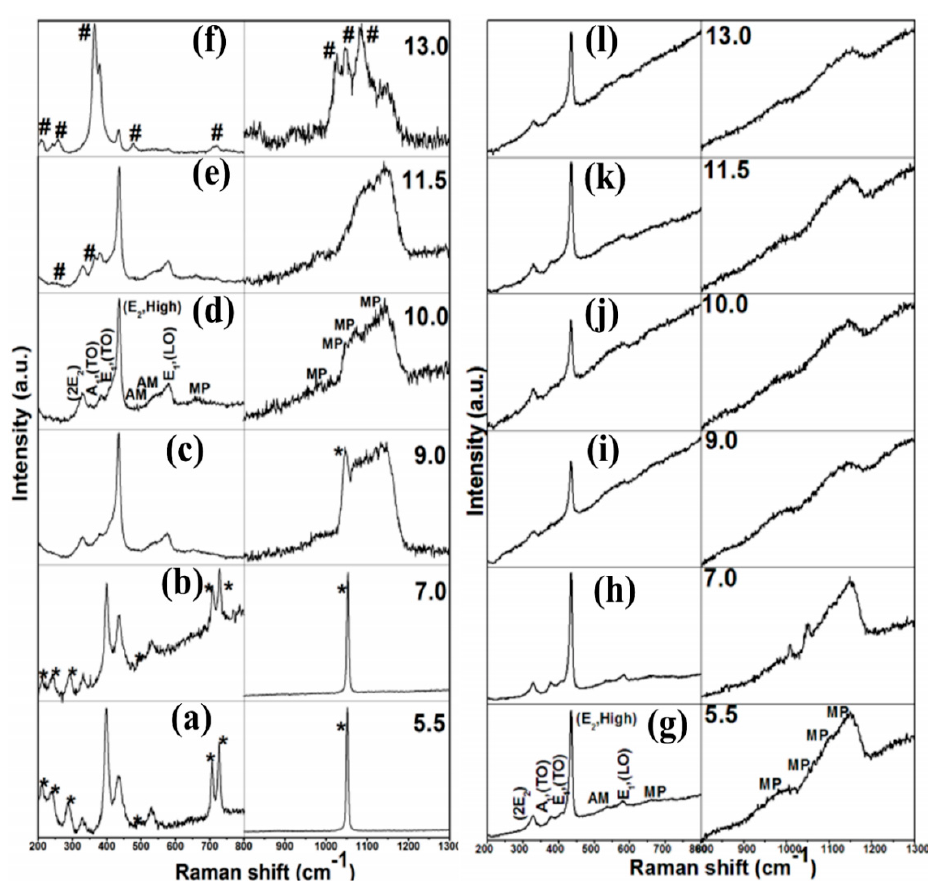
Figure 4. The Raman spectrum of synthesized ZnO powder: ( a )–( f ) for pH 5.5, 7, 9, 10, 11.5, and 13.0, respectively dried at 80 °C for 24 h; ( g )–( l ) for pH 5.5, 7, 9, 10, 11.5, and 13.0, respectively dried at 250 °C for 5 h.